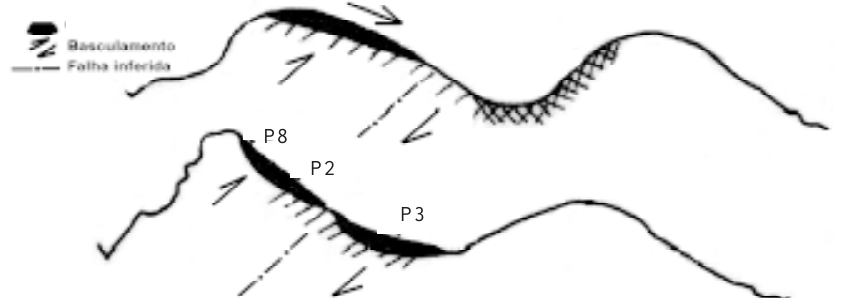
Figura 5. Esquema simplificado do transporte a curta distância do regolito, de SMI. (a) movimento de massa gerado pelo basculamento de blocos provoca transporte e (b) redistribuição do regolito ao longo do interflúvio do reverso dos blocos basculados.